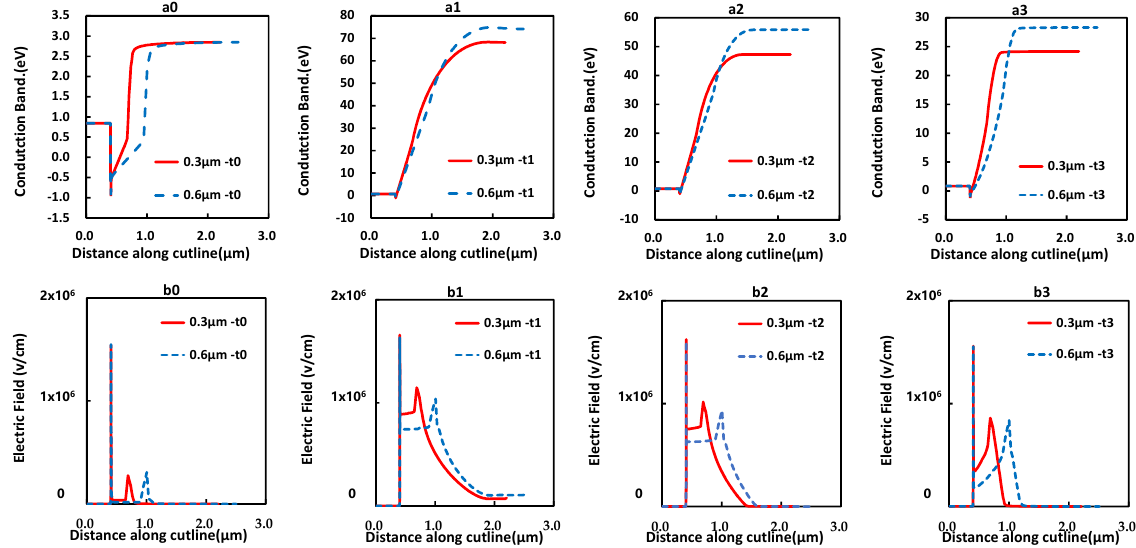
-1.5-1.0-0.50.00.51.01.52.02.53.03.5 Figure 13. Current collapse for UID thicknesses of 0.3 µ m and 0.6 µ m.